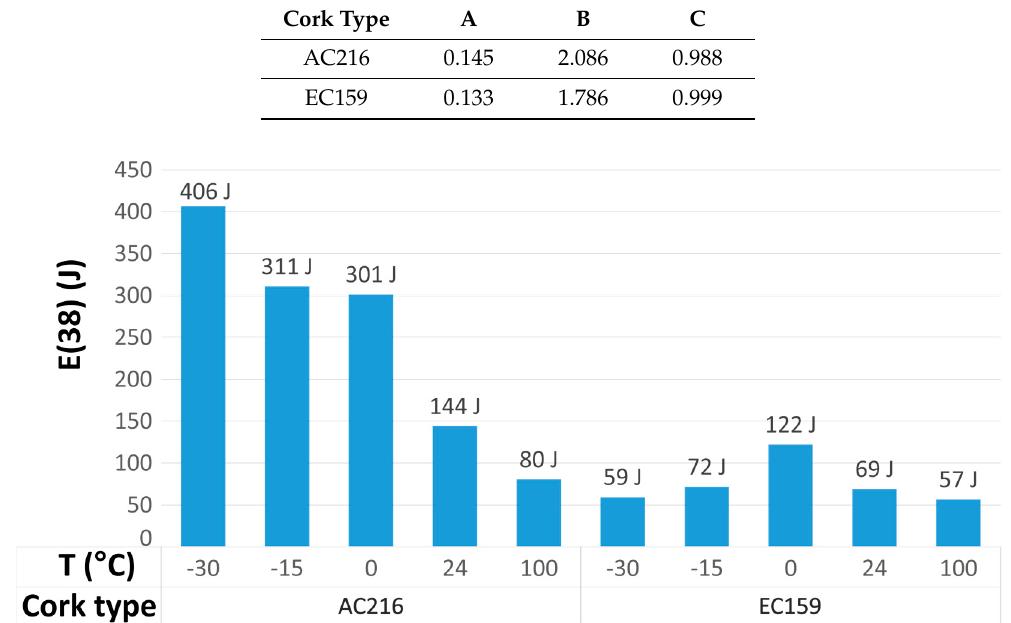
Figure 3. The influence of temperature on the absorbed energy at 38 mm deflection after 500 J impact for AC216 and EC159 based on